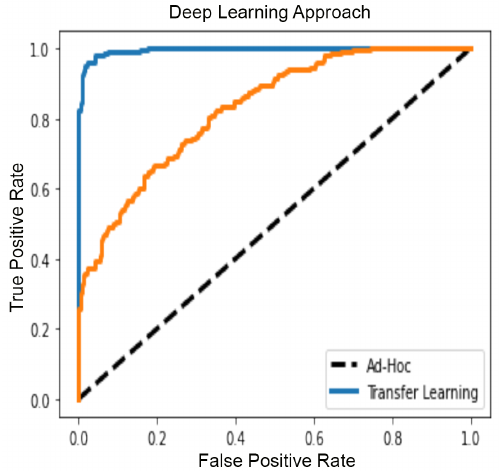
Figure 18. Comparison of ROC curves for the two deep-learning based approaches.